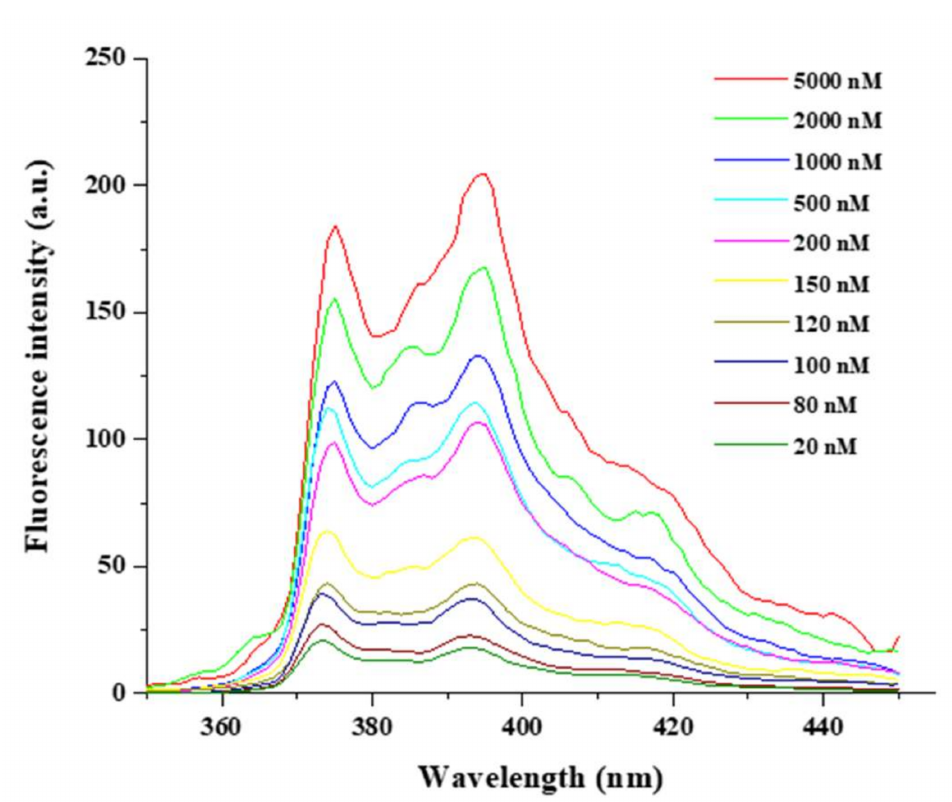
Figure A6. Fluorescence spectra of pyrene in different concentrations of affi-F/GQs